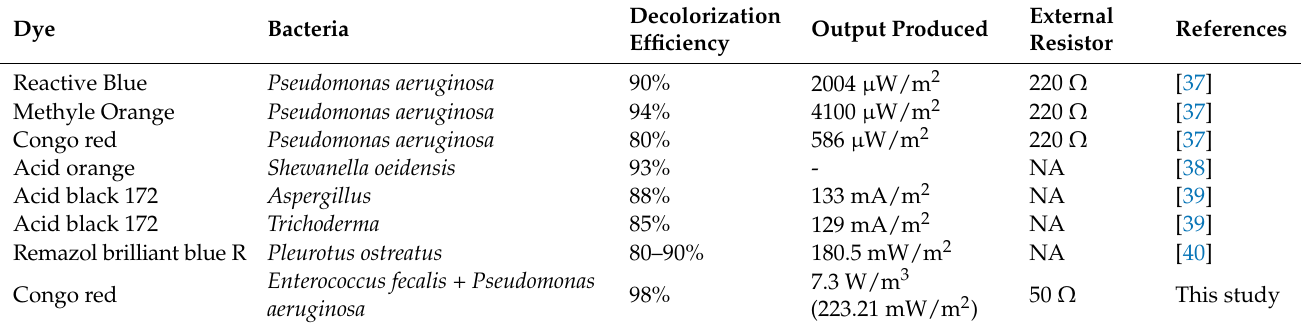
Table 2. Some reference comparisons regarding the performance of MFC.